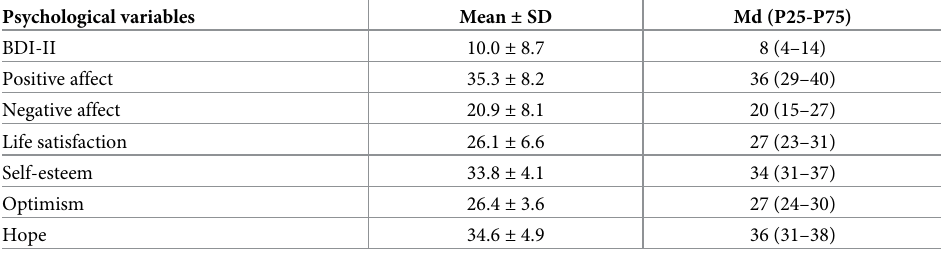
Table 3. Scores of the psychological variables applied to patients with metabolic syndrome, Porto Alegre, Brazil (n = 63).